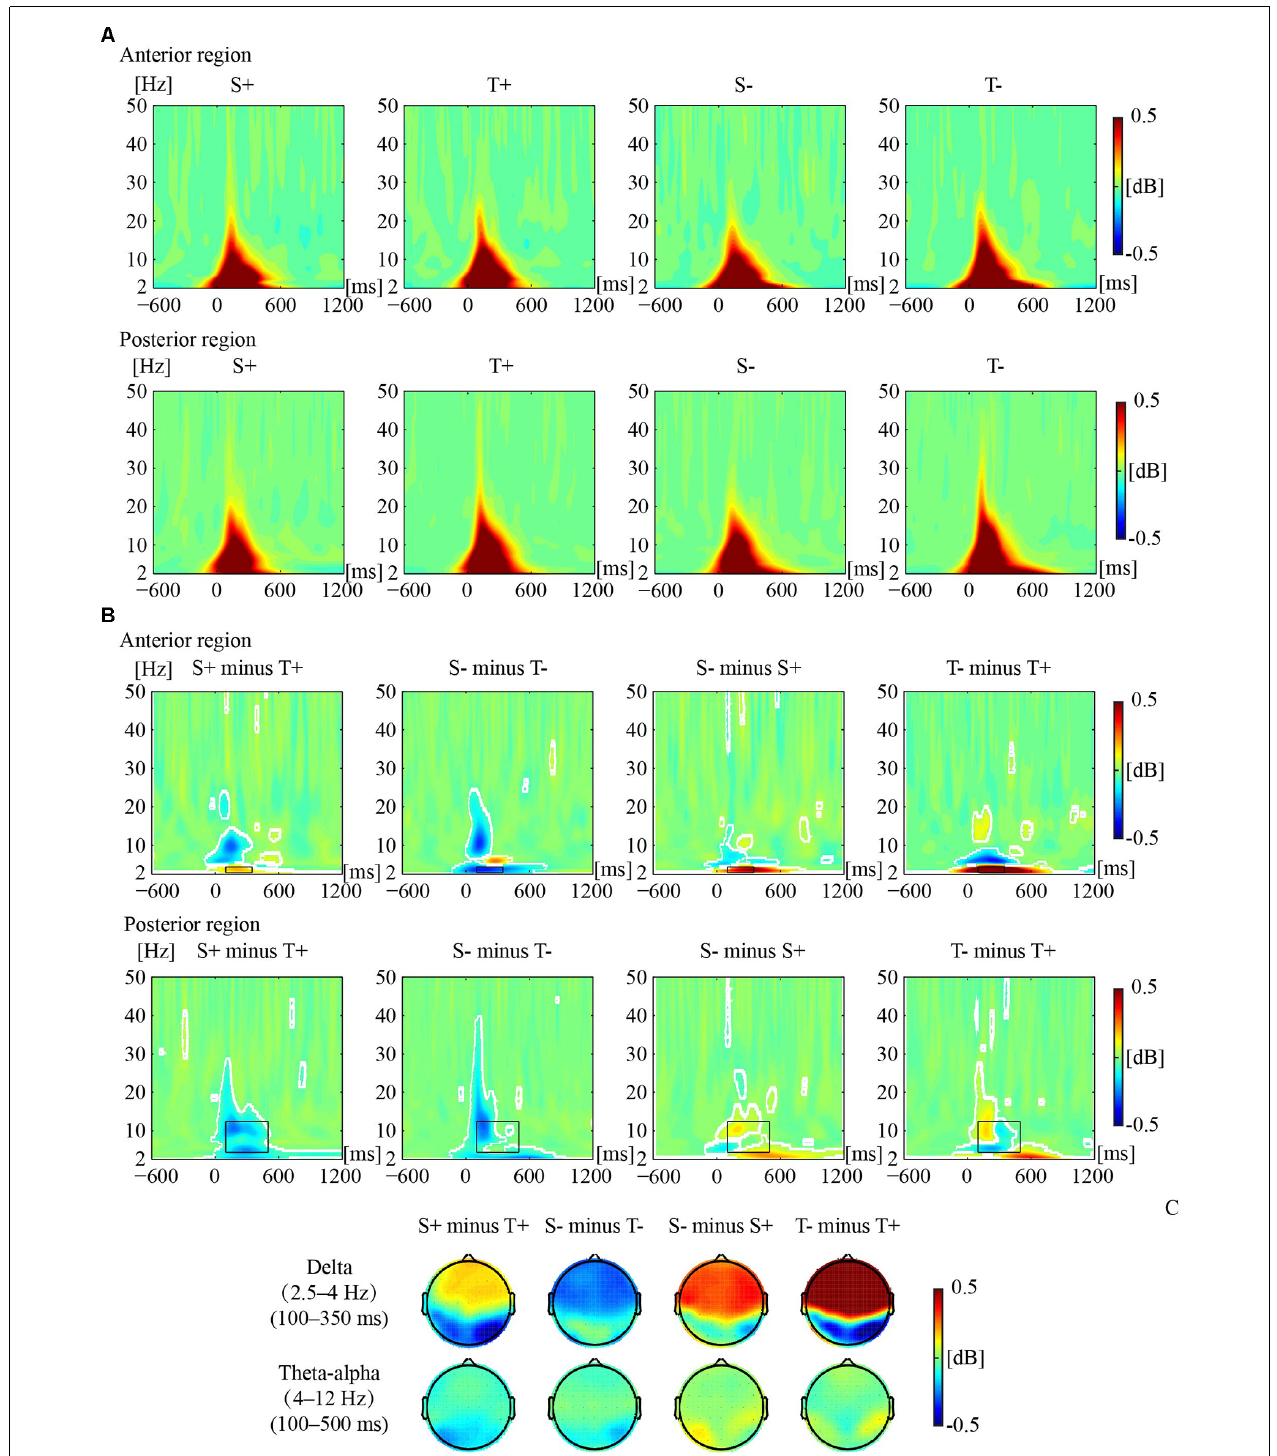
FIGURE 2 | Phase-locked electrophysiological (EEG) power responses to the premise monotonicity effect. (A) Grand-averaged power evoked by S+, T+, S − , and T − arguments in the anterior and posterior regions. (B) The EEG power of “S+ minus T+”, “S − minus T − ”, “S − minus S+”, and “T − minus T+” is shown in the anterior and posterior regions. White outlines indicate significant [ p < 0.01, false discovery rate (FDR) corrected] time–frequency pixels in the bootstrapping statistical analysis. Black outlines indicate time-frequency regions of interest (TF-ROIs) of the delta (2.5–4 Hz) and theta-alpha (4–12 Hz) bands. (C) Power difference topographies of the delta and theta-alpha